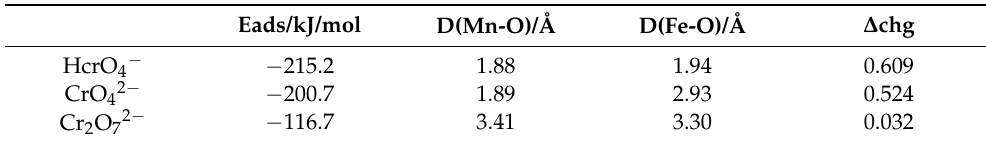
Table 4. The adsorption energy, the shortest distance between Mn/Fe and O, and the charge transfer between MnFe 2 O 4 − H (100) and adsorbates.